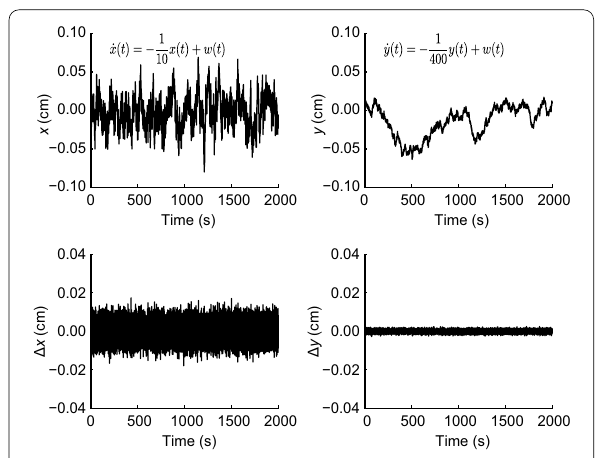
Fig. 1 Different correlation characteristics of two random processes. The upper subplots are two typical samples from the first-order Gauss–Markov process ˙ α( t ) = − 1 T α( t ) + w ( t ) , with w ( t ) ∼ N ( 0,2 σ 2 / T ) , where x and y have the same parameter σ but different correlation times T ; the lower two are defined as �α( t ) = α( t ) − α( t + � t